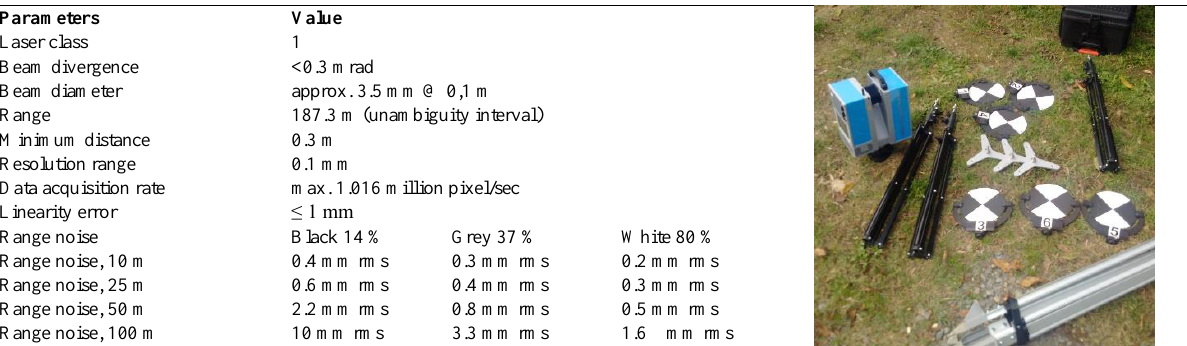
Table 1. Technical specification of laser scanner